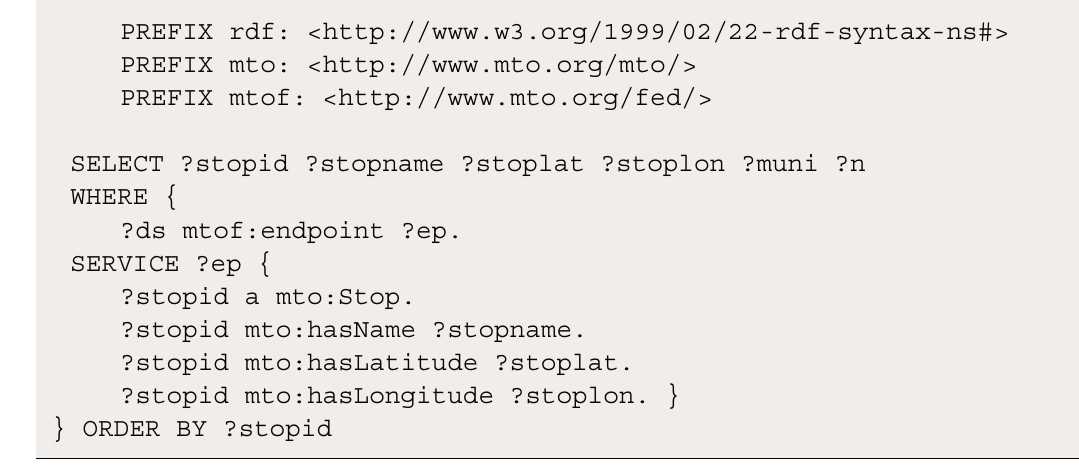
Figure 10. Federated SPARQL